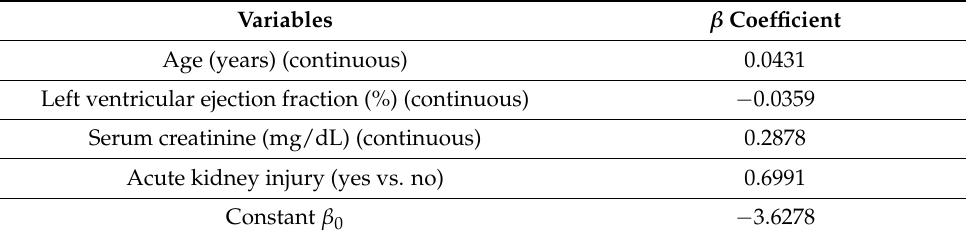
Table 2. Logistic regression model of long-term mortality risk score. Variables